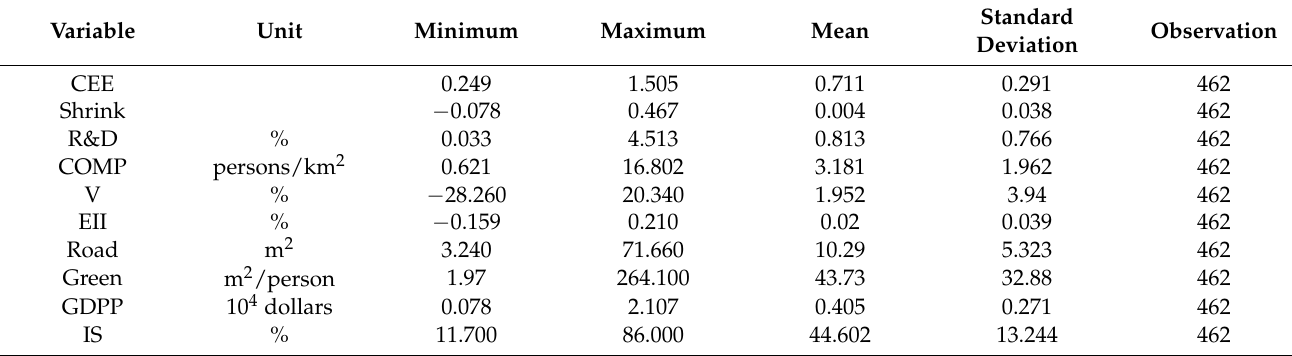
Table 2. Descriptive statistics of inputs and